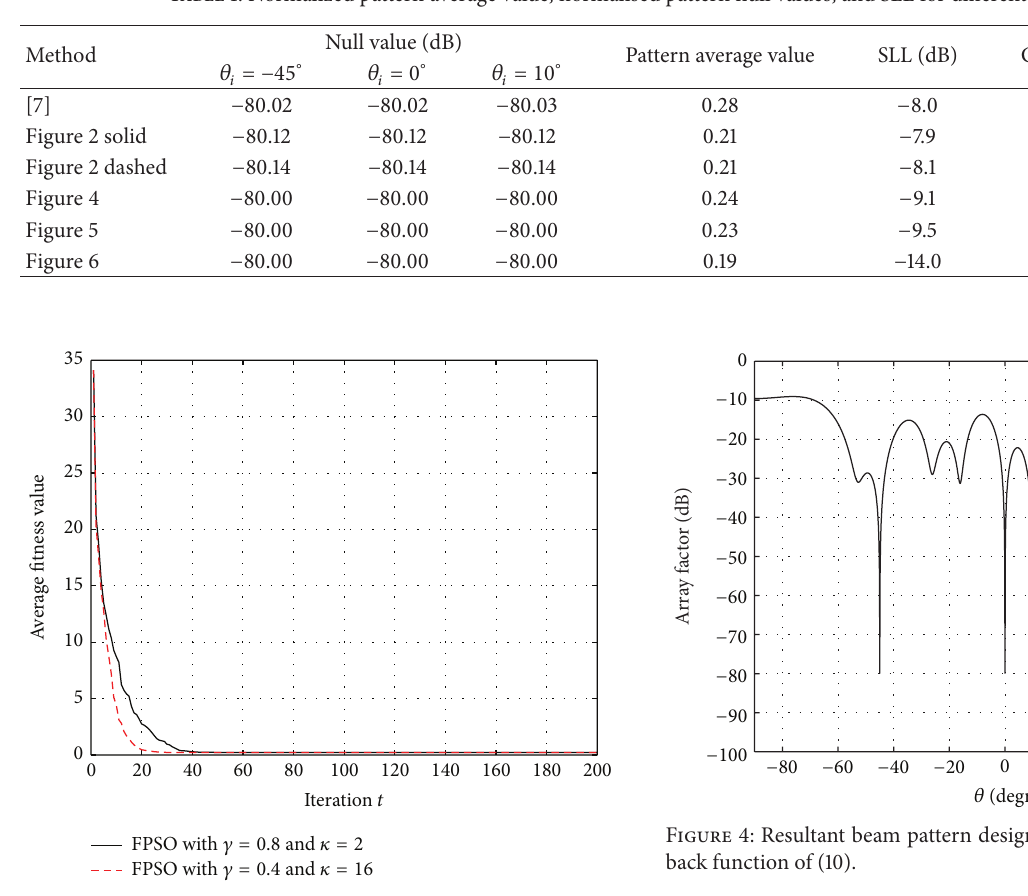
Figure 3: The mean convergence of fitness values with iteration (averaged over 10 trials) by the feedback function of (8) with 𝛾 = 0.8 , 𝜅 = 2 and 𝛾 = 0.4 , 𝜅 = 16 .